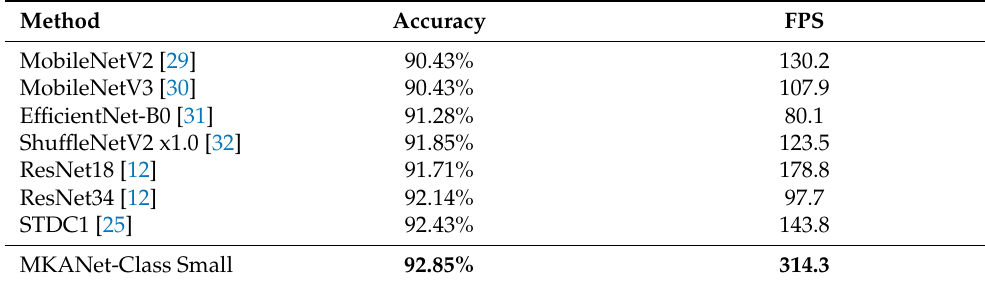
Table 2. Comparison of MKANet with other state-of-the-art, lightweight classification networks on the RSSCN7 dataset.